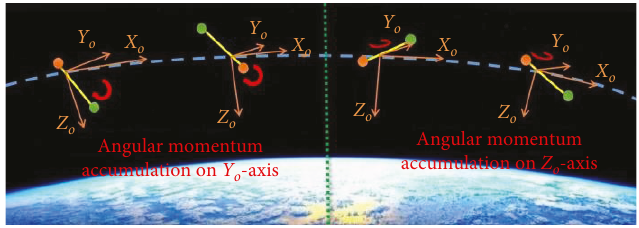
Figure 4: Diagram of angular momentum